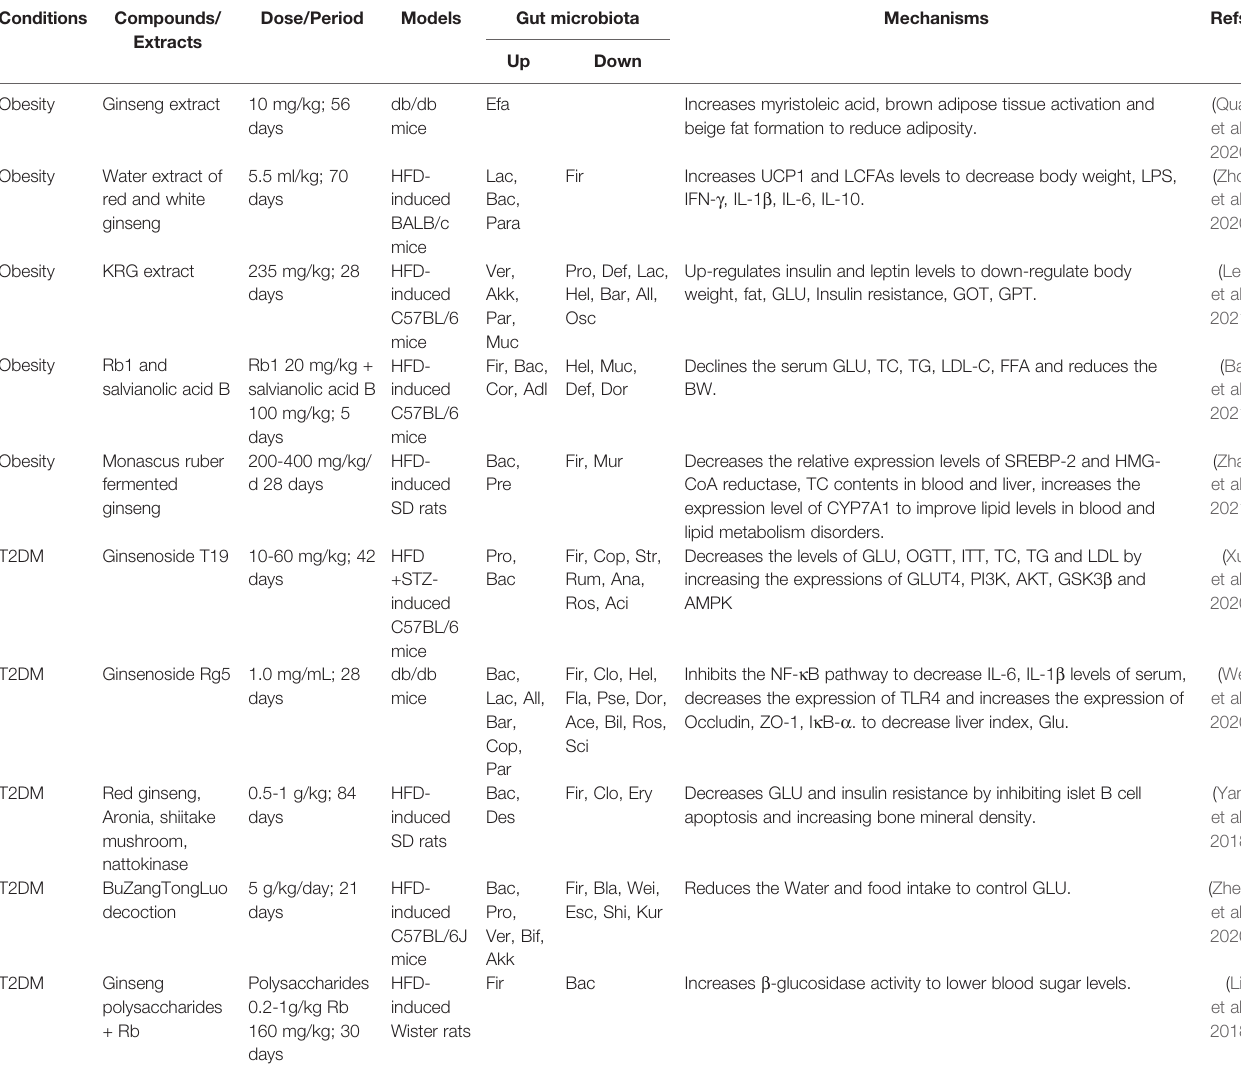
TABLE 1 | Summary of anti-obesity activities of ginseng by regulating gut microbiota and related pathways.